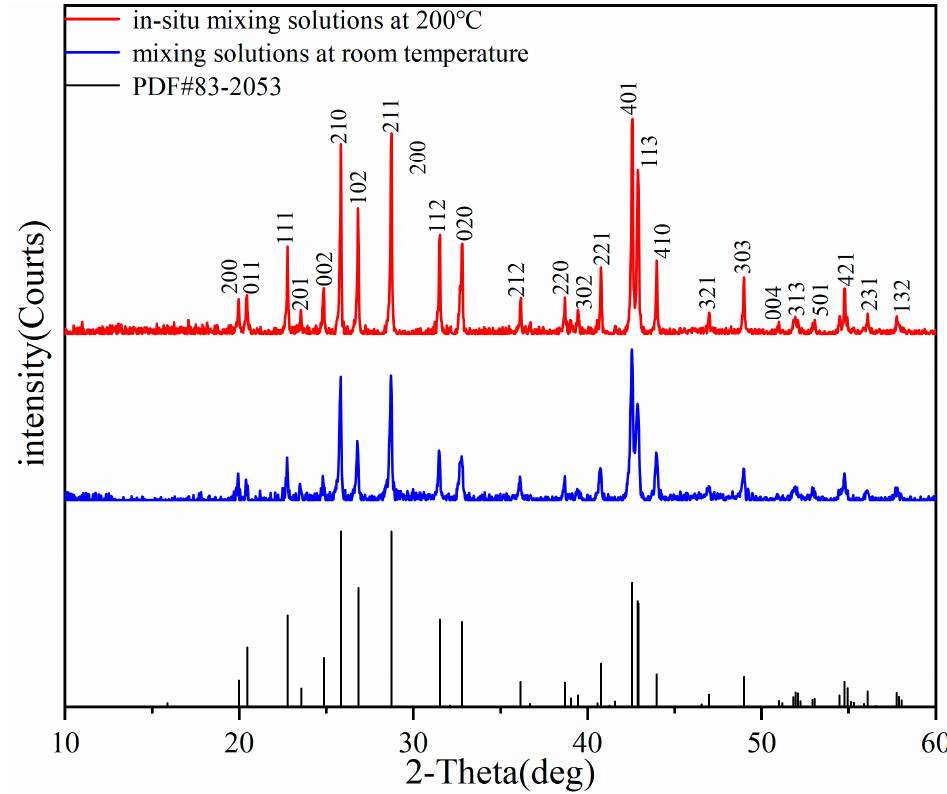
Figure 7. XRD diffractograms of barite synthesized by mixed solution at room temperature and in-situ mixing at 200 °C with an initial concentration of 0.03 mol/kg Na 2 SO 4 and BaCl 2 and a mixing ratio of 1:1, along with that of standard barite (PDF#83-2053).